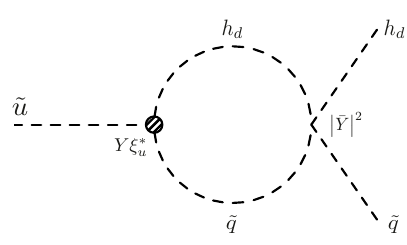
Figure 2 . Generation of new operator h y